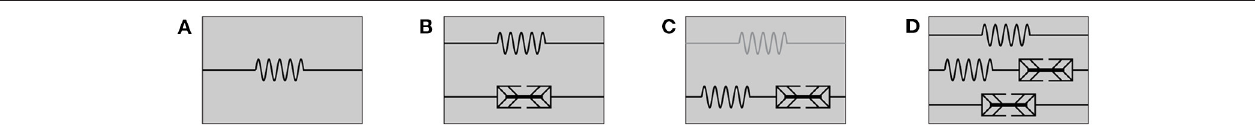
FIGURE 2 | Rheological models for (A) passive hyperelastic behavior, (B) the active-stress approach, (C) the active-strain approach, whereby an addition of a parallel elastic element (illustrated in gray) yields a generalized active-strain approach, and (D) the mixed-active-stress-active-strain approach.